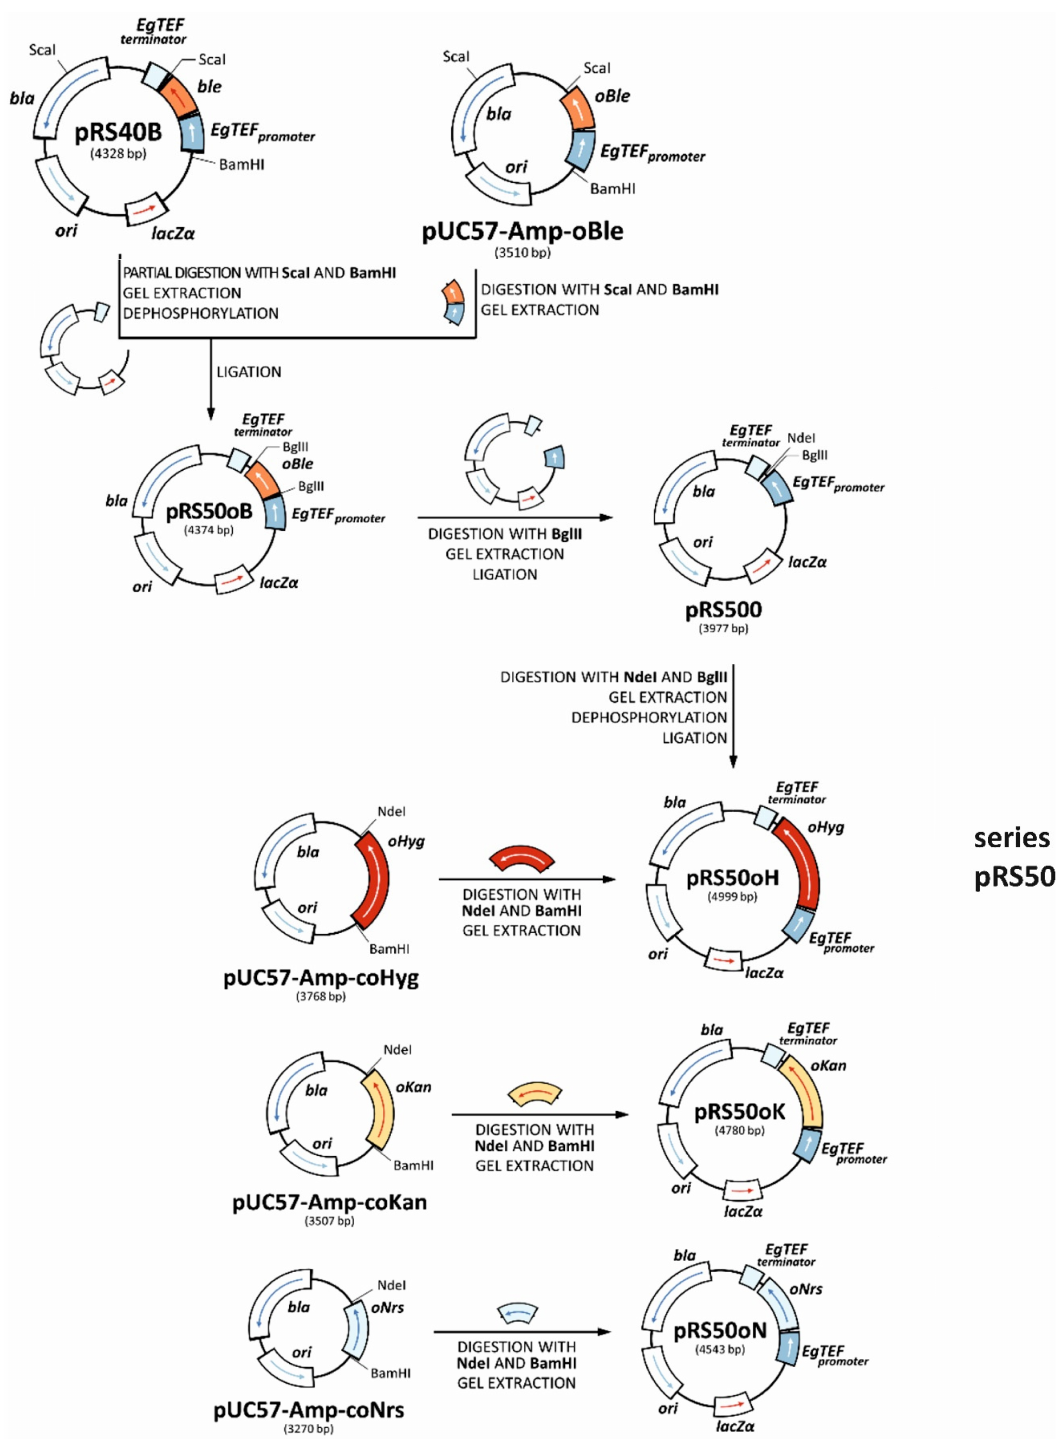
Figure 1. Construction of the plasmid series pRS50 (integrative plasmids) with a detailed list of intermediate cloning steps and relevant restriction sites. ble = original ble ORF from Klebsiella pneumoniae, EgTEFpromoter = promoter of the Eremothecium gossypii TEF gene, EgTEFterminator = terminator of the E. gossypii TEF gene, oBle = codon-optimized ble ORF encoding for resistance to phleomycin, oHyg = codon-optimized ORF encoding for resistance to hygromycin B, oKan = codon-optimized ORF encoding for resistance to G418, oNrs = codon-optimized ORF encoding for resistance to clonNAT, bla = resistance to ampicillin, ori = replication origin from the E. coli plasmid pBR322, lacZ α = gene encoding α -peptide required for the blue-white